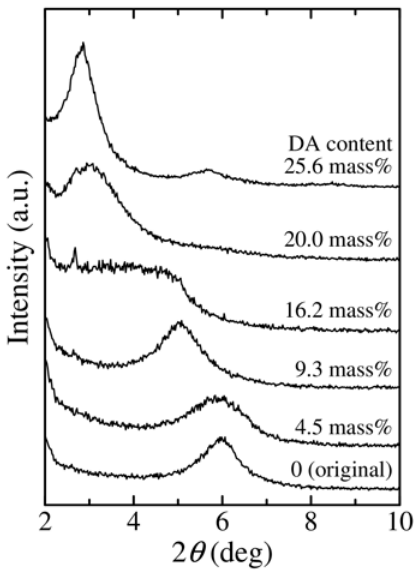
Figure 1. XRD patterns of samples with different DA contents.